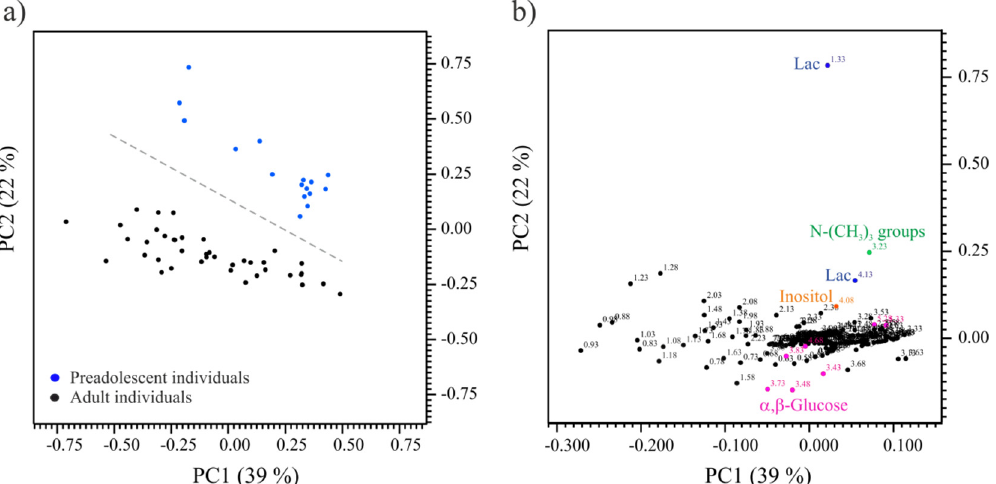
Figure 2. ( a ) PCA scores plot (PC1-PC2) from 1H NMR spectral data of follicular fluid samples of prepubertal (n = 16; blue dots) and adult (n = 40; black dots) goats. ( b ) PCA heat map loadings plot (PC1-PC2) with some discriminant variables assigned.